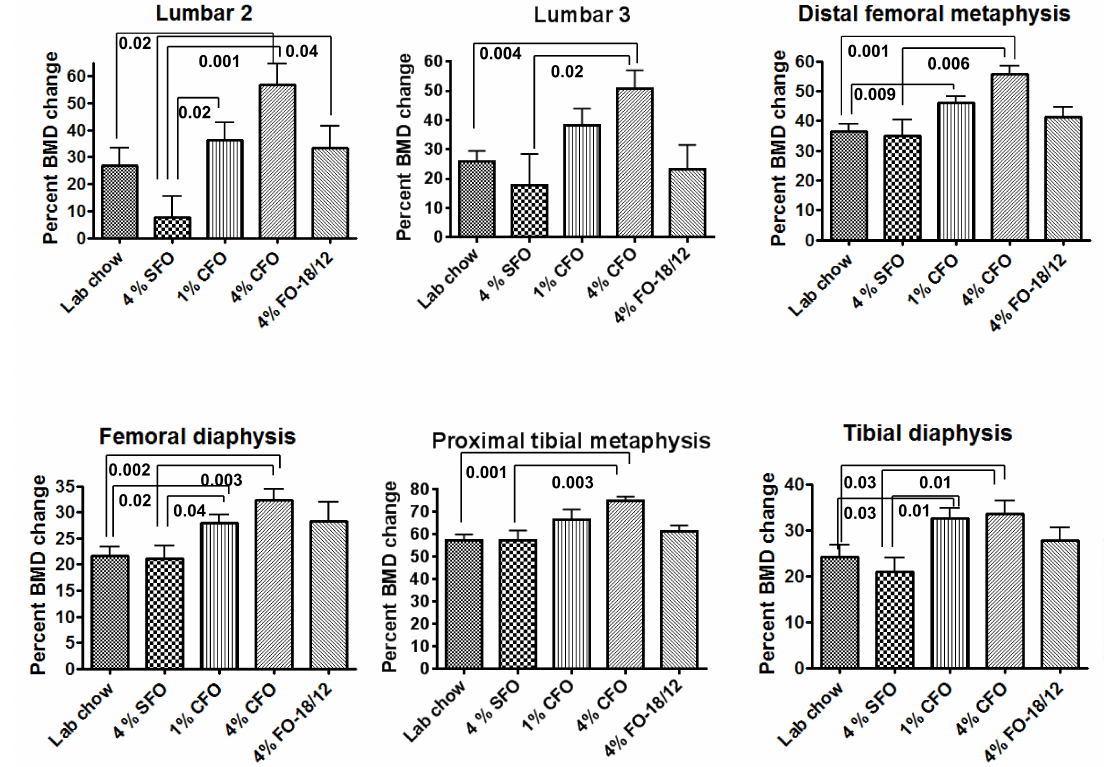
Figure 2. CFO maintains higher levels of bone mineral density during aging. A DXA scan was performed at 12 months of age just before starting the experimental diets to determine the baseline bone mineral density value. Twelve-months-old C57Bl / 6 mice were fed experimental diets for 12 months and then another DXA scan was performed to determine the endpoint bone mineral density value. The percent change bone mineral density (BMD) value was analyzed from the endpoint value to the baseline value. Each value represents the mean ± S.E.M. n = 8–9 mice per group. P -value < 0.05 was considered significant by Student’s t-test. The number denotes the p-value. SFO, sa ffl ower oil containing 70%–80% ω -6 linoleic acid; CFO, concentrated fish oil containing 46.5% EPA and 37.5% DHA; FO-18 / 12, regular fish oil containing 18% EPA and 12%